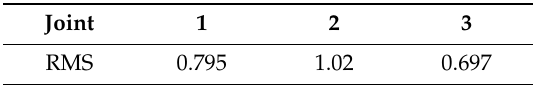
Table 2. Root mean squared (RMS) error between the calculated friction based on LuGre model and the referred